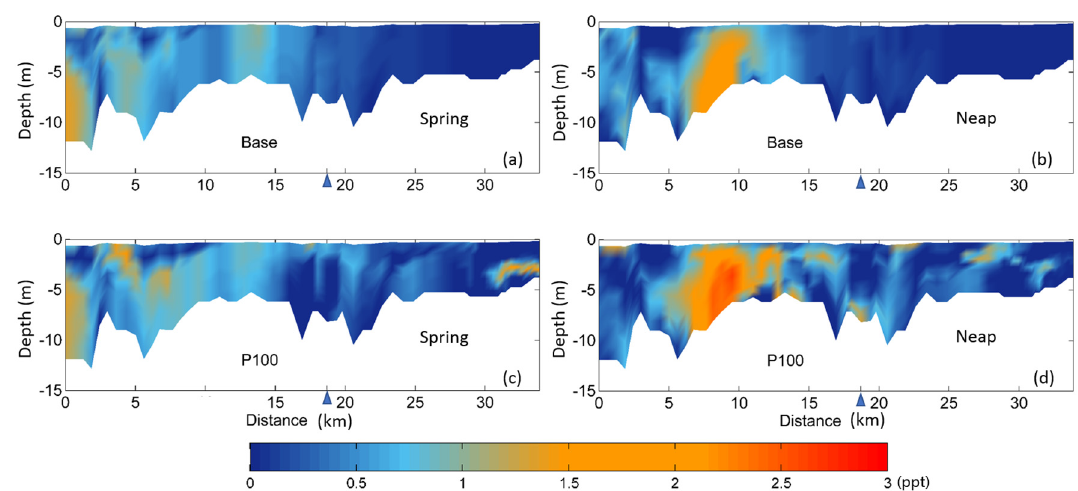
Figure 11. Vertical profiles of salinity change ( ∆ S = S t2 − S t1 ) during a flood tide along the tributary where Xintang is located. Here, S t1 represents the salinity at the beginning of the flood tide and S t2 that at the end of the flood tide. The results obtained during a typical spring tide ( a , c ) and typical neap tide ( b , d ), for the base case ( a , b ) and the case with 100-cm sea-level rise ( c , d ). The triangle indicates the location of